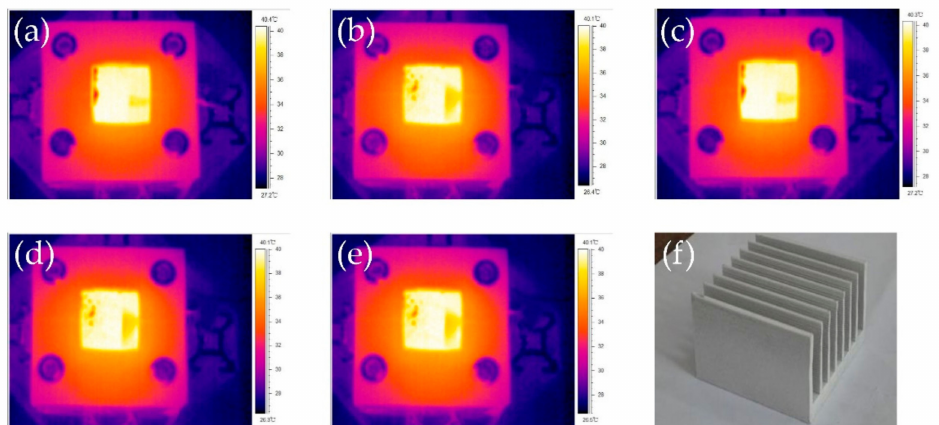
Figure 8. The IR thermal images of heat sink surfaces with thermal radiation coating on different treated surfaces: ( a ) without surface treatment; ( b ) chemical polishing; ( c ) chemical coarsening; ( d ) mechanical shot peening; ( e ) chemical oxidation; ( f ) photo of heat sink with thermal radiation